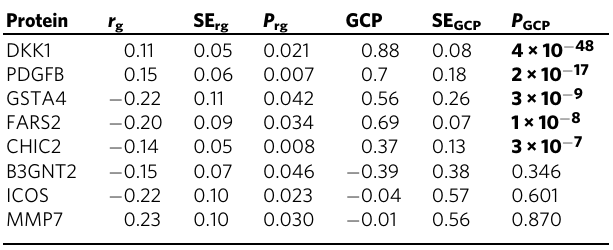
Table 2 Causal relationship between blood proteins and